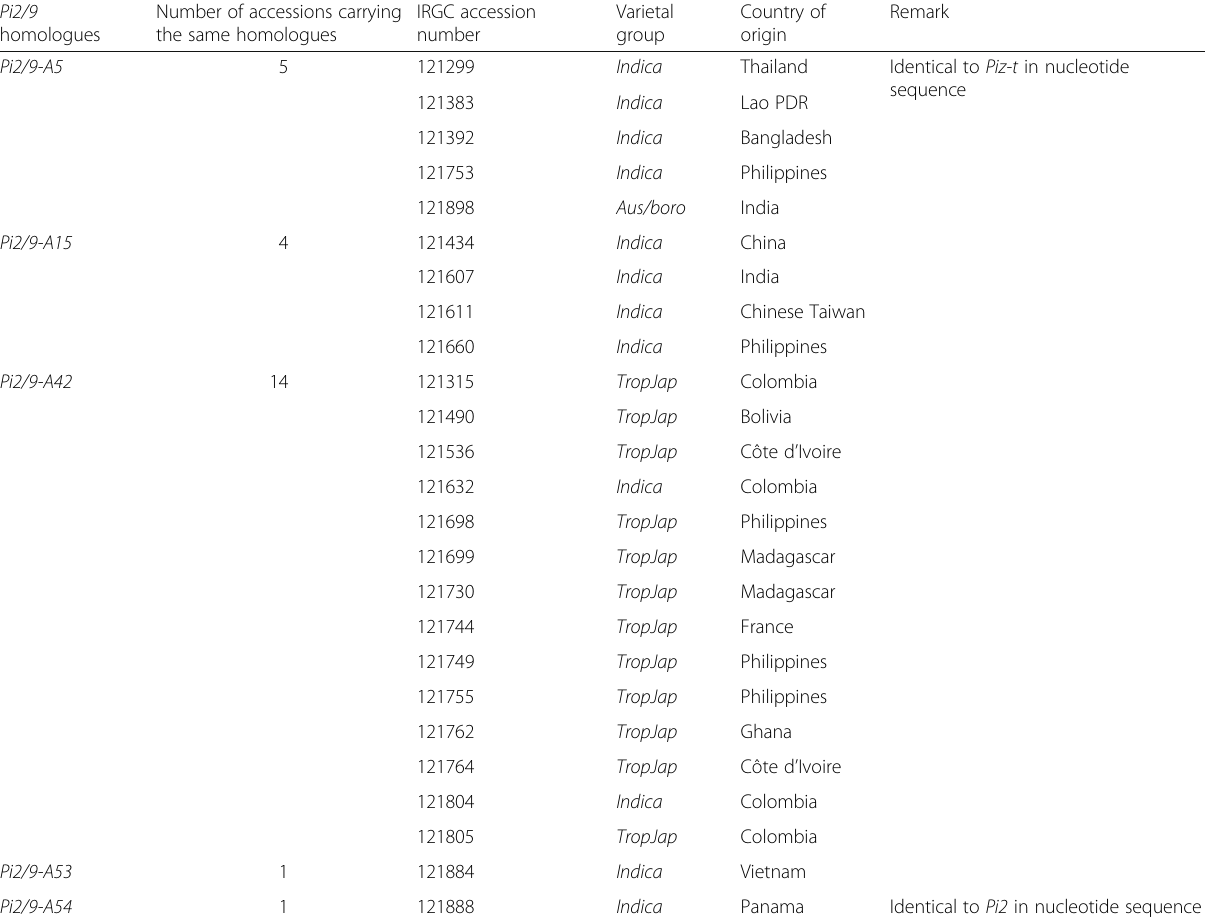
Table 3 Clustering of 25 Pi2/9-RH positive rice lines by sequencing the Pi2/9 homologues Pi2/9 Number of accessions carrying homologues the same